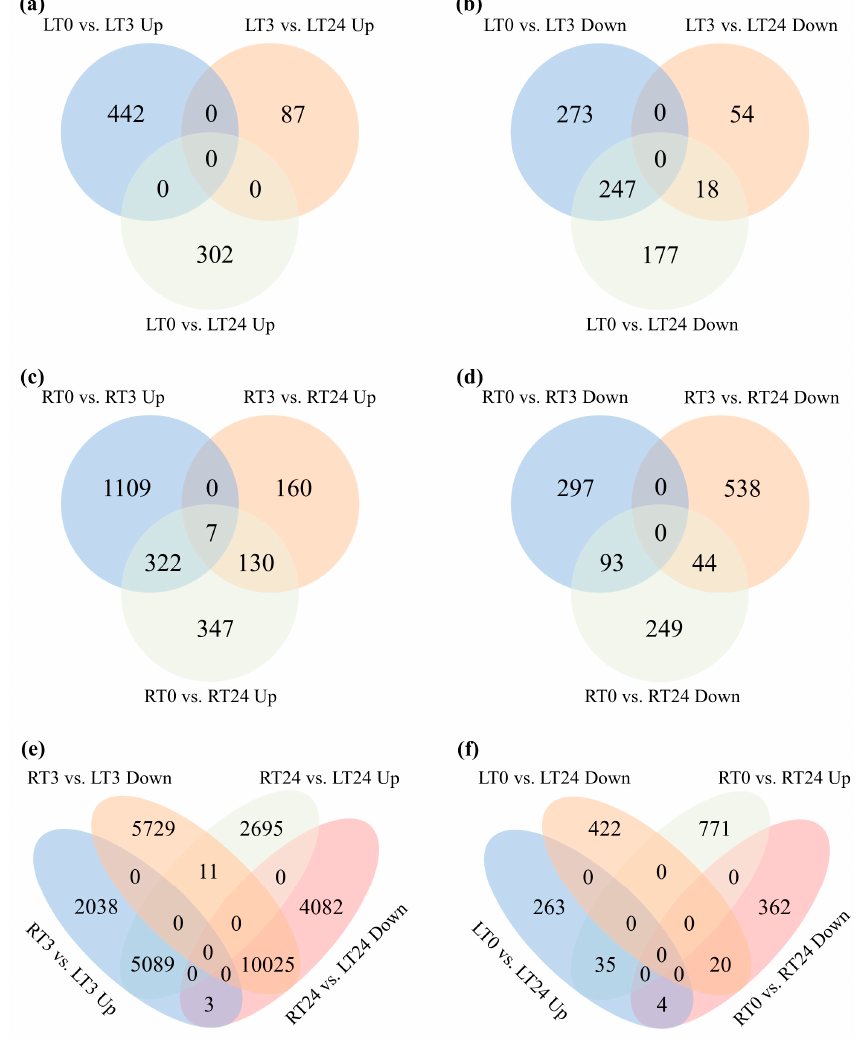
Figure 3. Venn diagrams of differentially expressed genes. Overlaps among up-regulated genes following CdCl 2 exposure in leaves ( a ), down-regulated genes following CdCl 2 exposure in leaves ( b ), up-regulated genes following CdCl 2 exposure in roots ( c ), down-regulated following CdCl 2 exposure in roots ( d ), up and down-regulated genes following CdCl 2 exposure at T3 and T24 in organs ( e ), up and down-regulated following CdCl 2 exposure at T0 and T24 in organs ( f ).